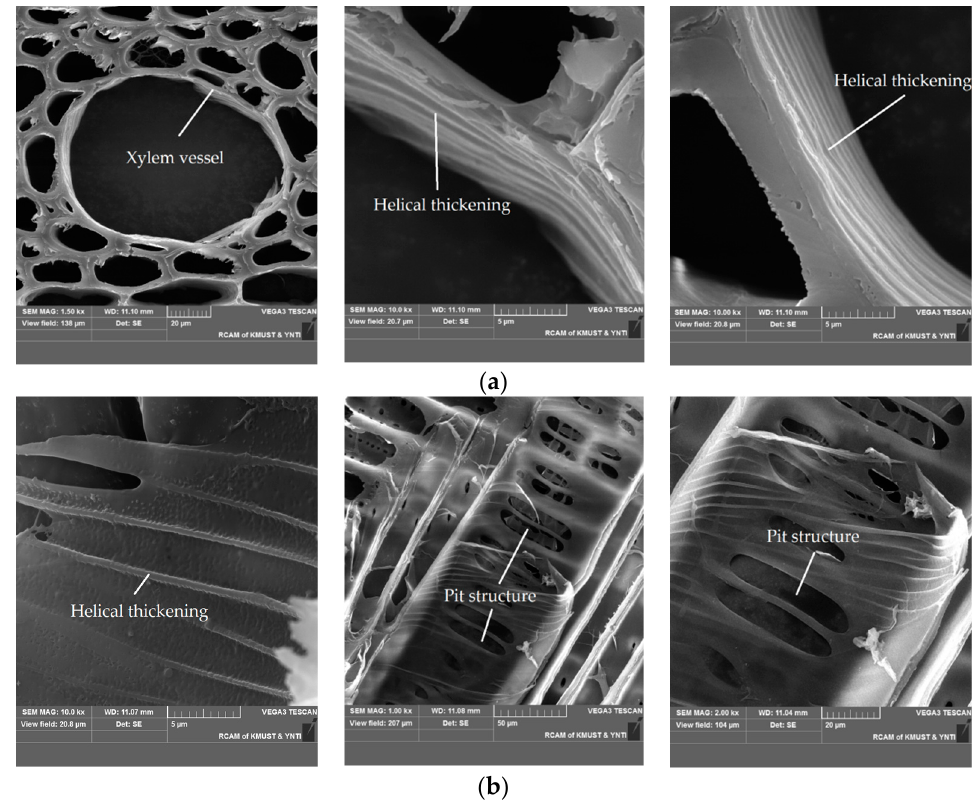
Figure 2. Original SEM images of the cross-sectional and axial sectional structures of Magnolia : ( a ) microscopic images of a cross-section of the vessel sample; ( b ) microscopic images of an axial section of the vessel sample.